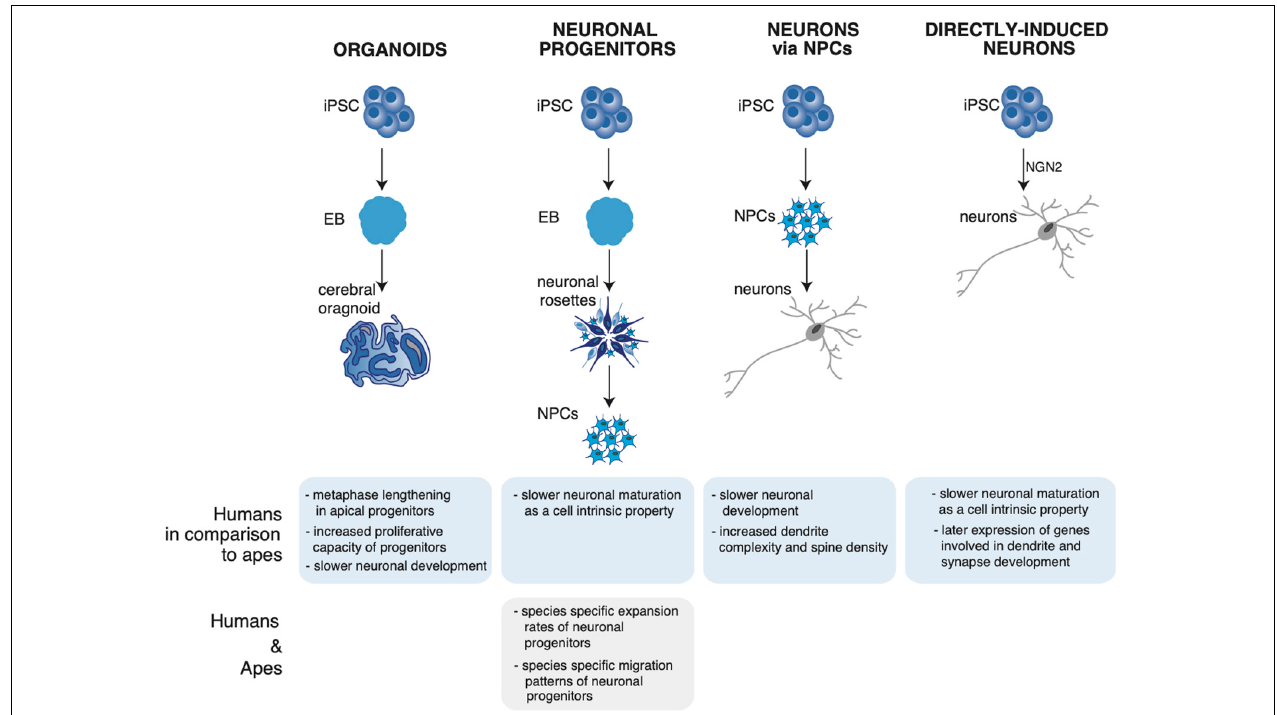
FIGURE 1 | Summary of neuronal phenotypes observed in human and ape neuronal models. The figure shows the differentiation of induced pluripotent stem cells (iPSCs) into cerebral organoids (Mora-Bermudez et al., 2016; Kanton et al., 2019; Pollen et al., 2019; Benito-Kwiecinski et al., 2021), neural progenitors (NPCs) (Otani et al., 2016), neurons via NPCs (Marchetto et al., 2019), and directly induced neurons (Schörnig et al., 2021). (Bottom) Observed neuronal phenotypes in the respective neuronal system and their uniqueness in either humans or non-human apes. iPSC, induced pluripotent stem cells; EB, embryoid body; NPC, neuronal progenitor; NGN2,